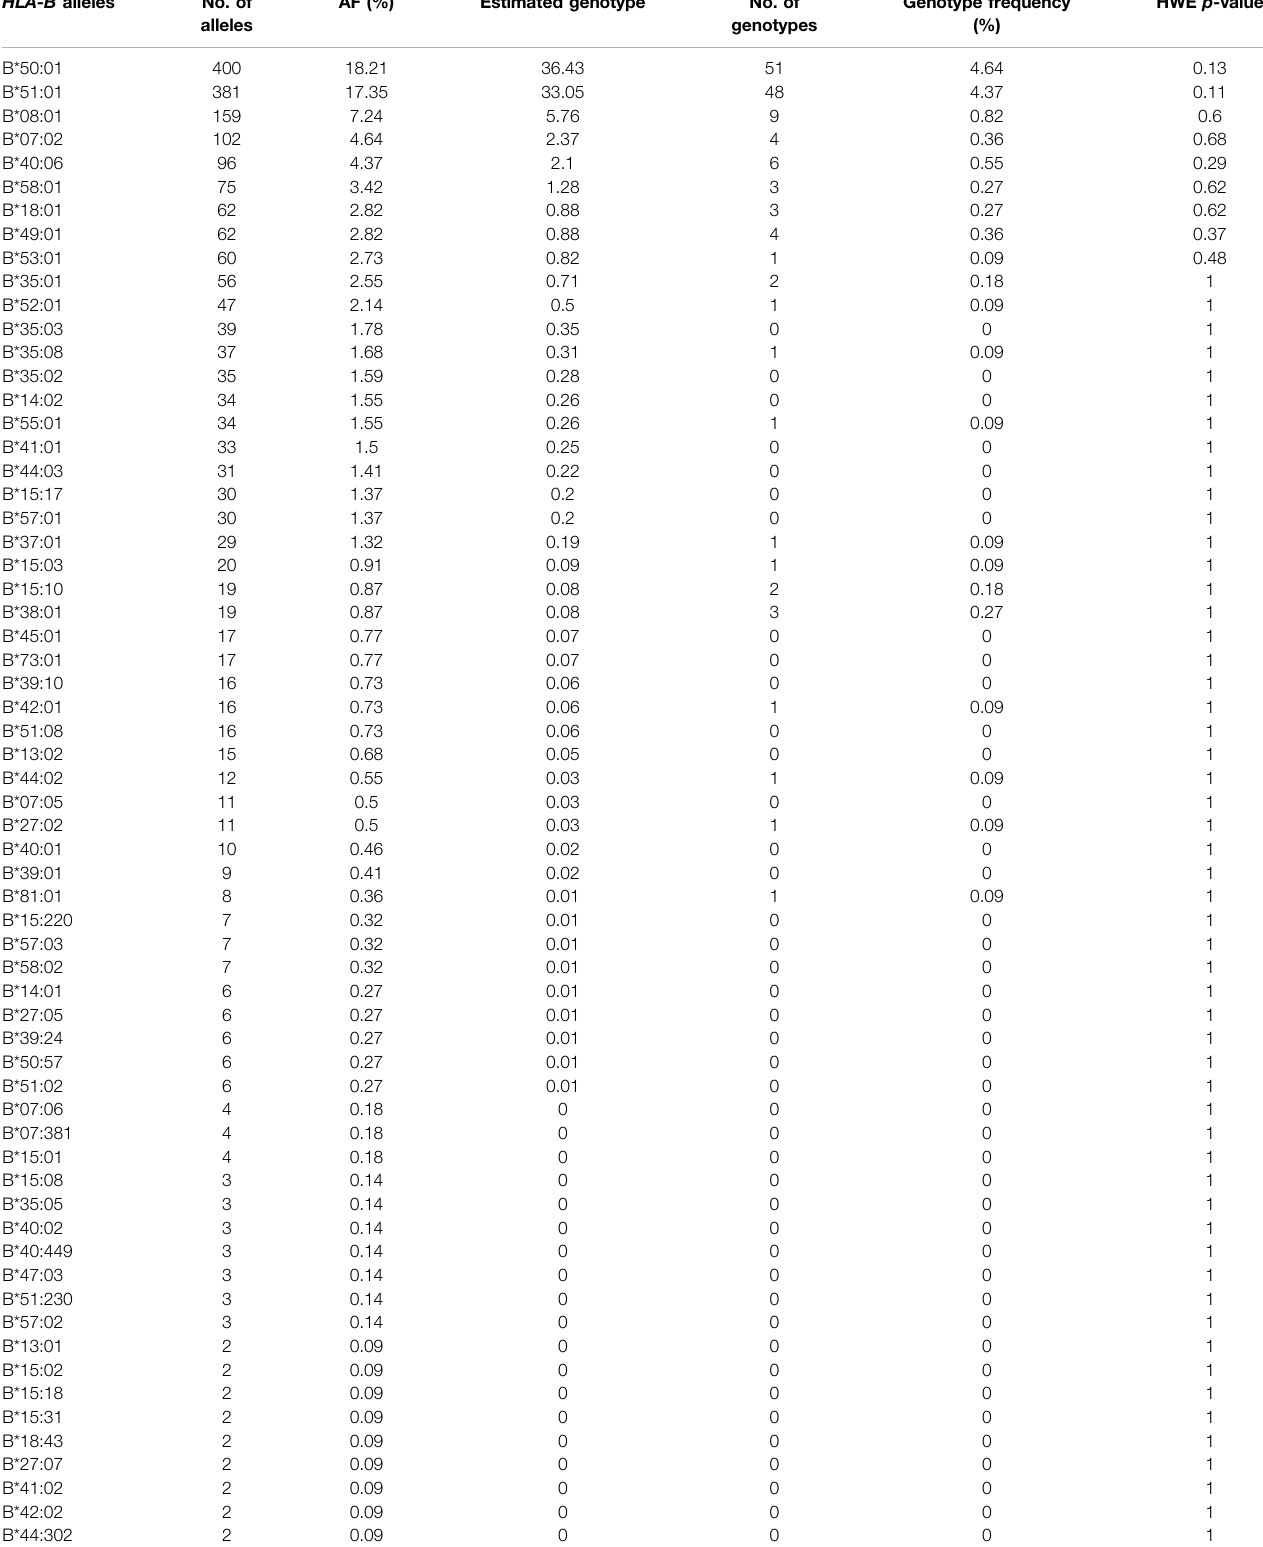
TABLE 2 | HLA-B alleles ( n > 1) frequency in Qatari population. HLA-B